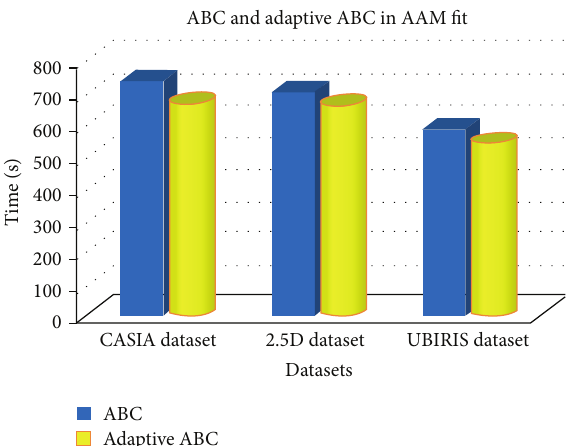
Figure 5: The average time taken to fit the model in the original image by conventional and adaptive ABC over the three datasets.